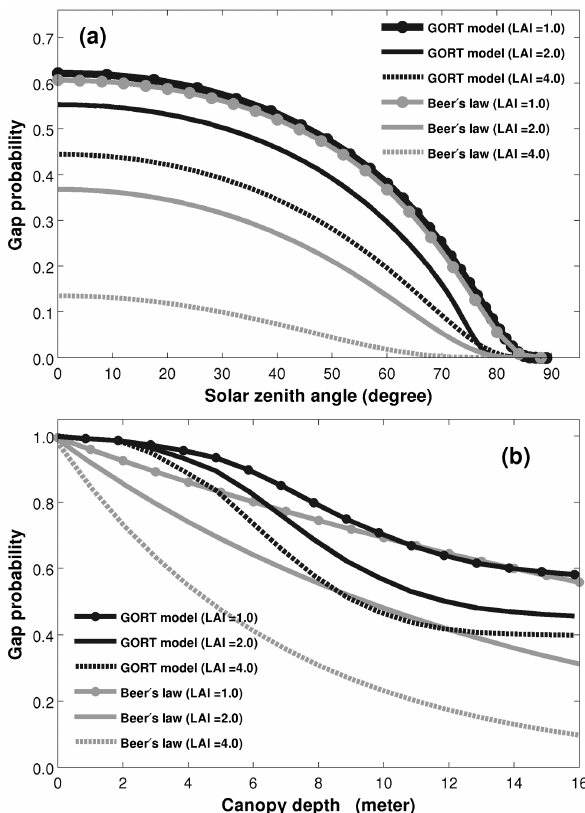
Figure 3. Comparisons between canopy gap probabilities modeled using GORT and Beer’s law as a function of (a) solar zenith angle and (b) canopy depth. The canopy depth is defined as the distance from canopy top to a canopy height ( h) . Tree structure parameters for the US-Bar site are used in GORT